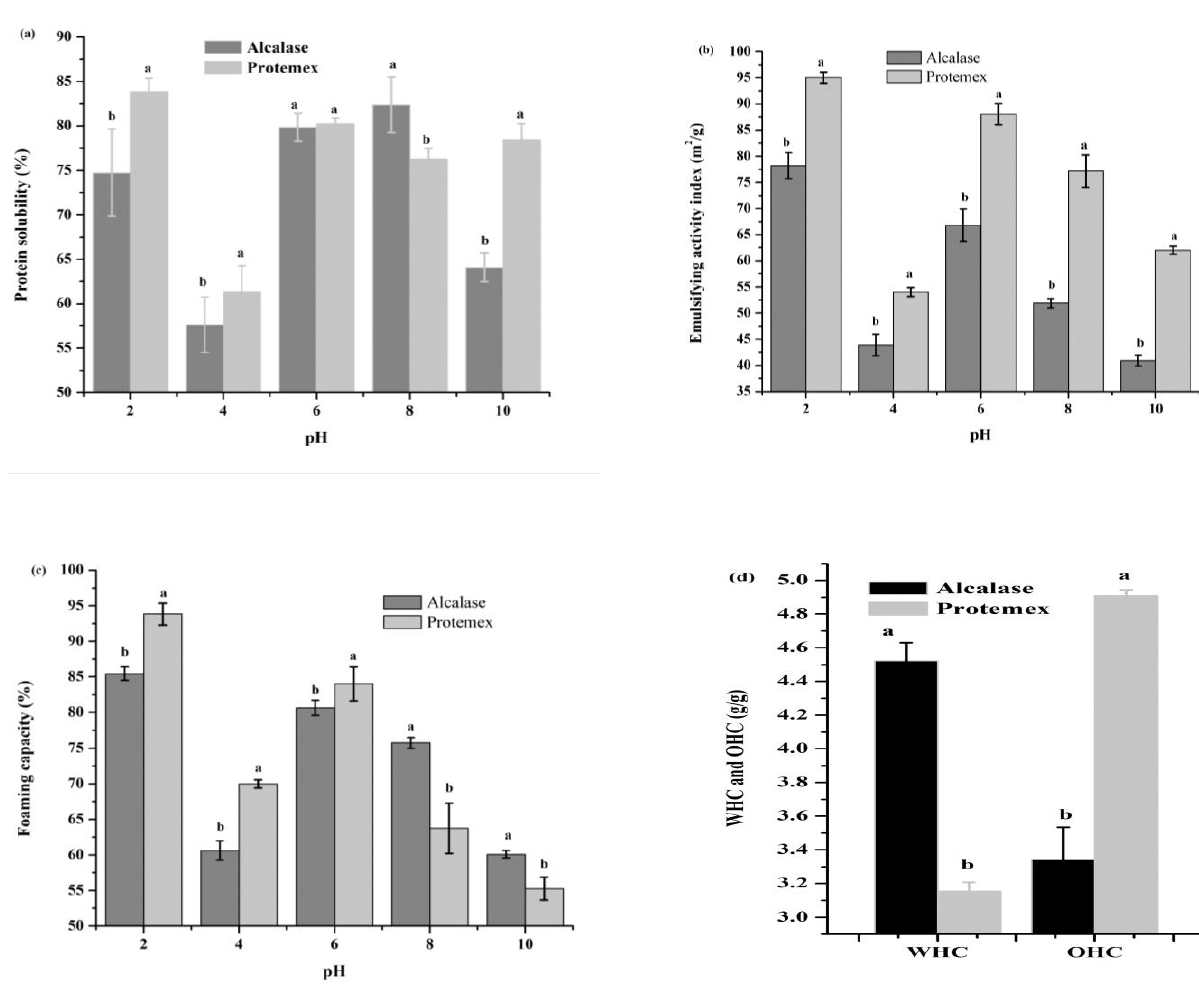
Figure 2. Functional properties of soybean protein hydrolysate: ( a ) protein solubility (%), ( b ) emulsi- fying activity index (m 2 /g), ( c ) foaming capacity (%), and ( d ) water- and oil-holding capacity (g/g). The values represent means of three independent experiments ± SD. Different characters indicates significant differences at each pH ( p < 0.05).